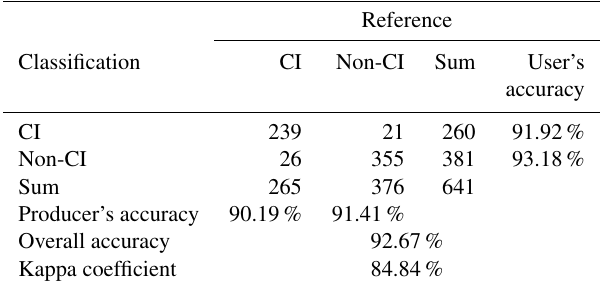
Table 6. Assessment of the probabilistic RF model for CI detection using the test data set. CI probabilities above 50% are considered